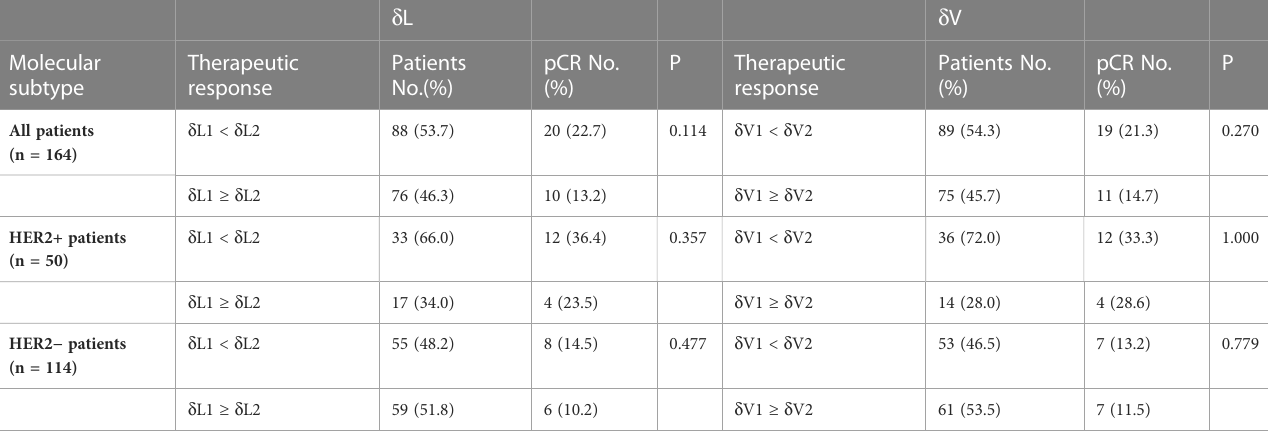
TABLE 2 pCR rates were similar between groups when evaluated by d L and d